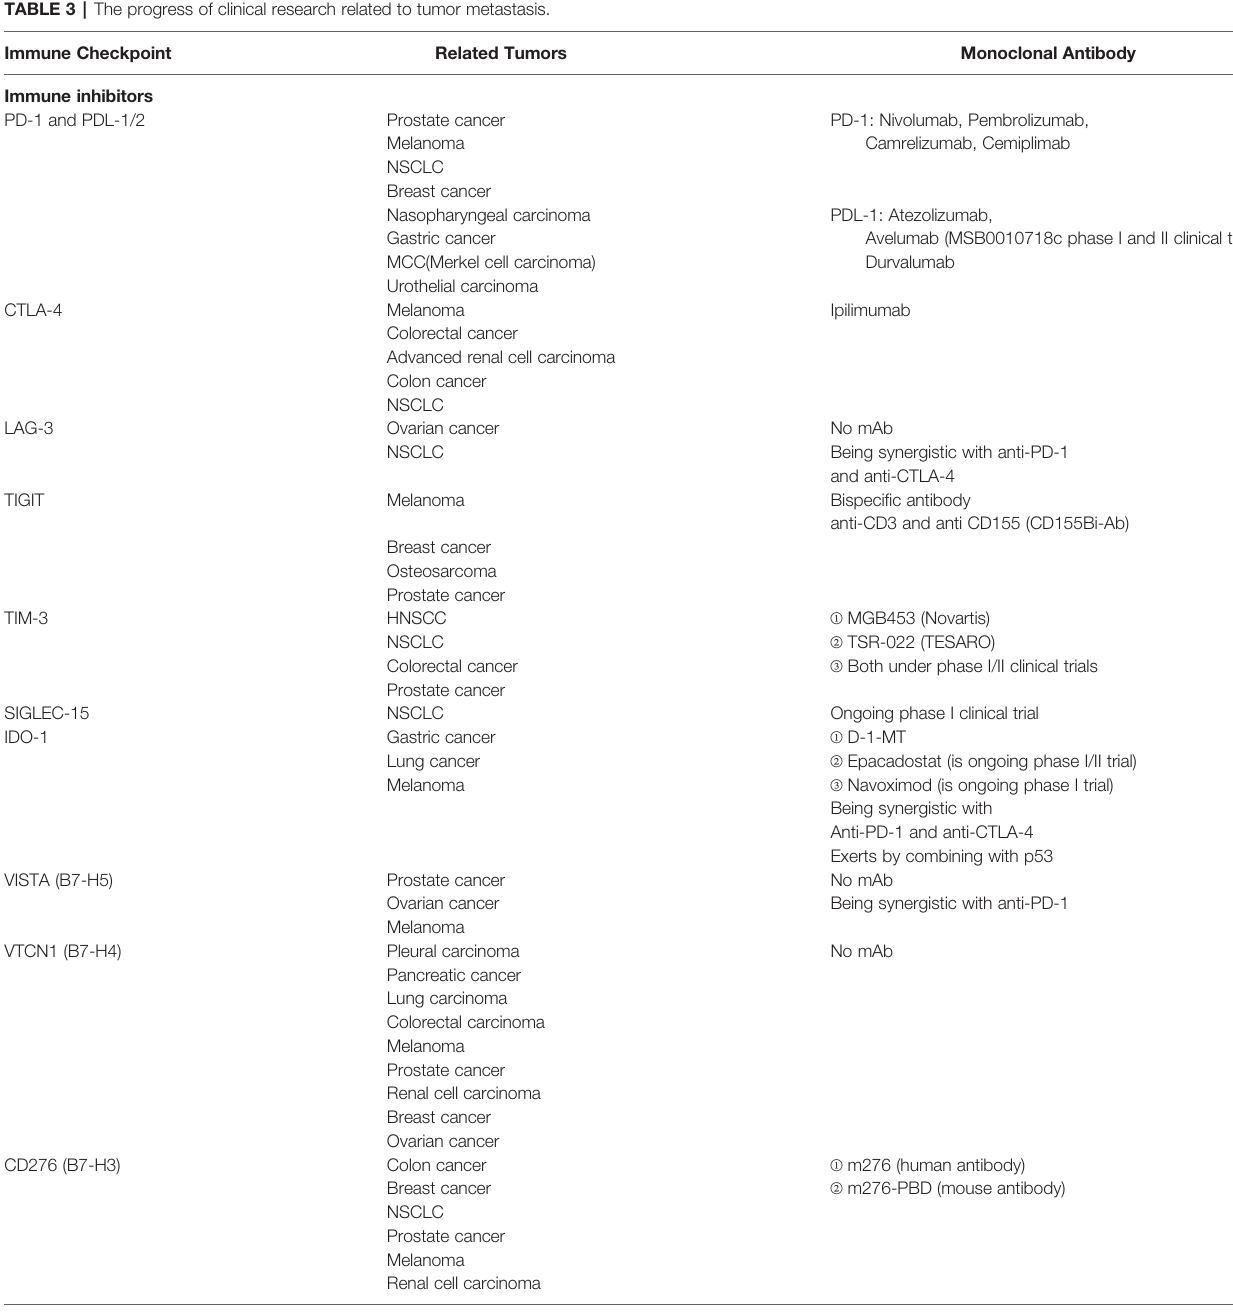
TABLE 3 | The progress of clinical research related to tumor